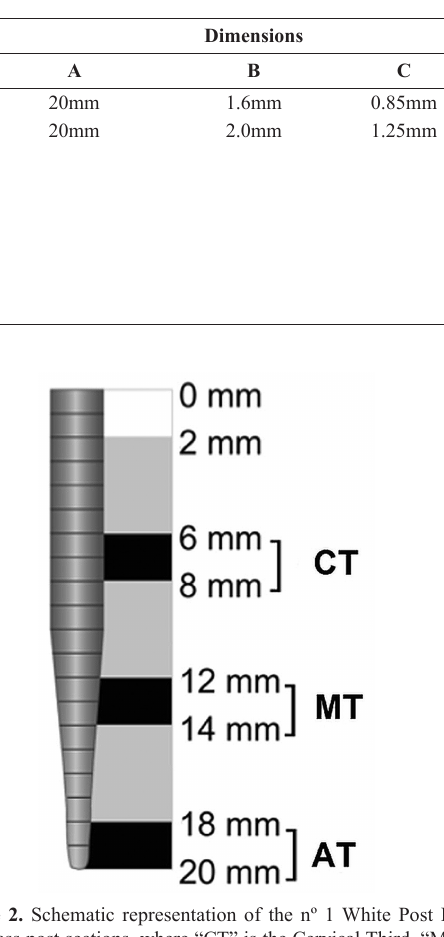
Table 2. Fiberglass post dimensions.